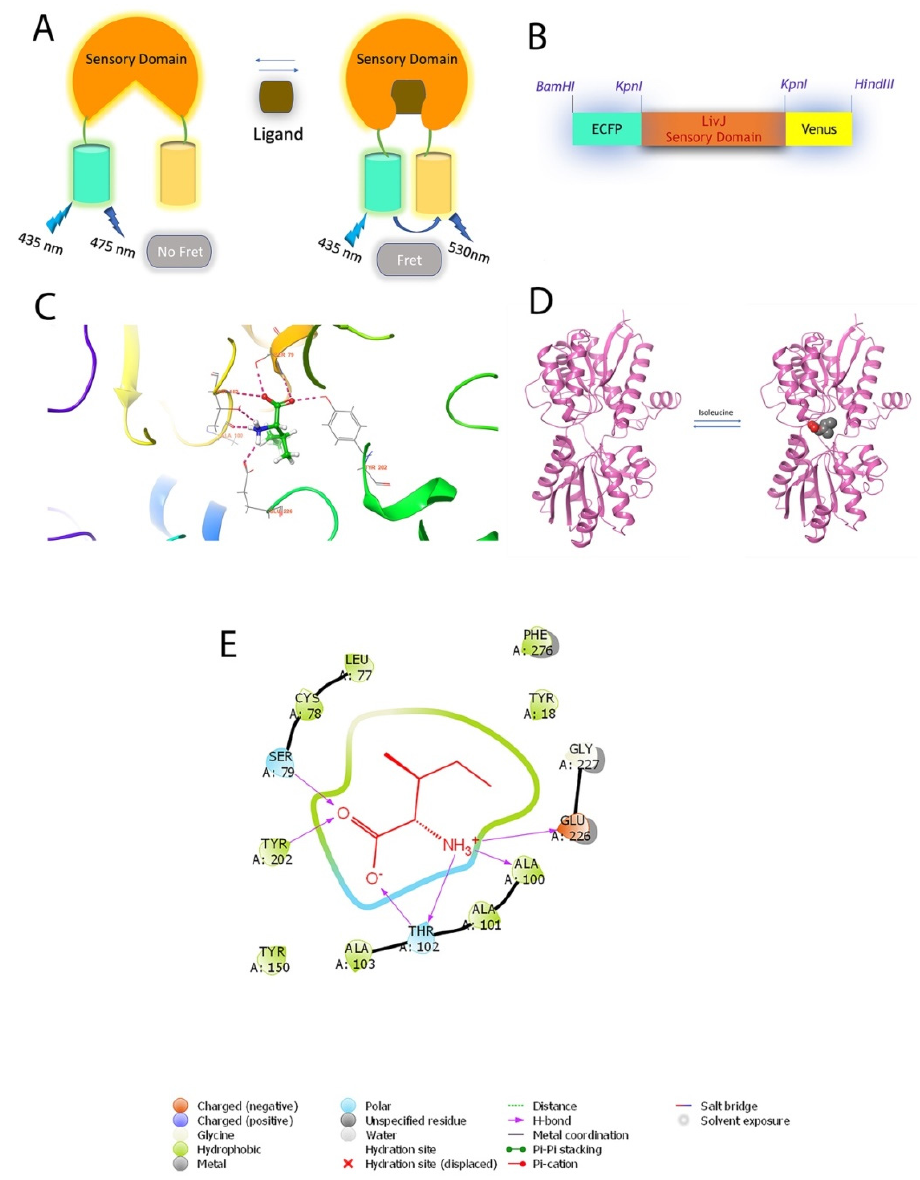
Figure 1. Designing of nanosensor. ( A ) Generic representation of the Förster / Fluorescence Resonance Energy Transfer (FRET) mechanism with sensor protein attached to Enhanced Cyan Fluorescent Protein (ECFP) and Venus. In the absence of ligands, the sensory domain exists in an open form with the inter-fluorophore distance being large enough so as to preclude any FRET (fluorescence emission only by ECFP at 475 nm). On binding with the ligand, the sensor takes on a closed form bringing the attached fluorescent proteins within FRET permissible range, resulting in fluorescence emission by Venus at 530 nm. ( B ) Schematic representation of the GEII sensor with LivJ as the sensory domain and ECFP / Venus as the fluorescent pair. Restriction sites are also depicted. ( C ) Docking pose of LivJ in complex with isoleucine. Ball and stick form represent isoleucine. ( D ) Pictorial representation of the open and closed forms of the LivJ binding protein in the absence, and presence of isoleucine, respectively. ( E ) Interactions of the active binding site in the LivJ-isoleucine bound complex as determined from docking studies carried out using Schrödinger suite.